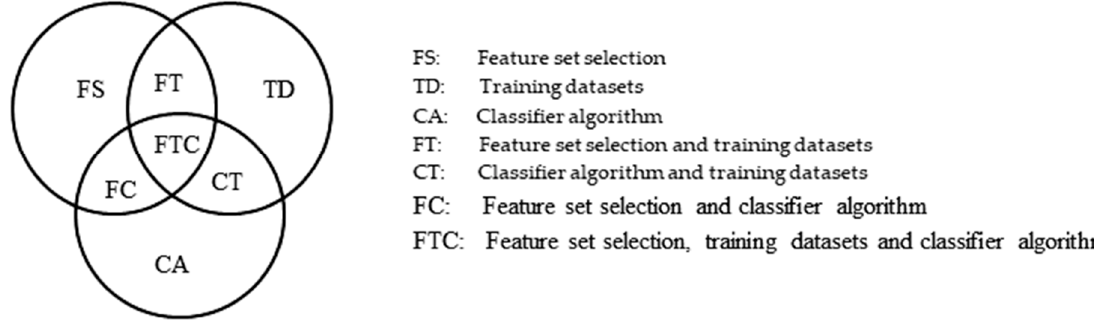
Figure 6. Levels of evasion scenarios for the classifier system [153]. Table 11. Influence of attacker classifier by attacker